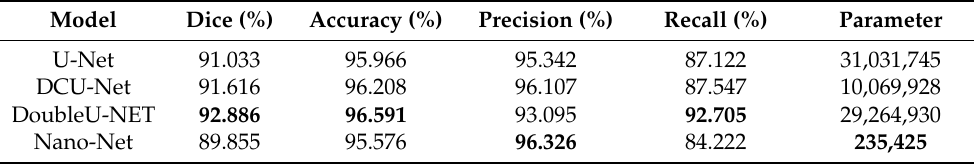
Table 3. Result (in %) of segmentation models using data augmentation.